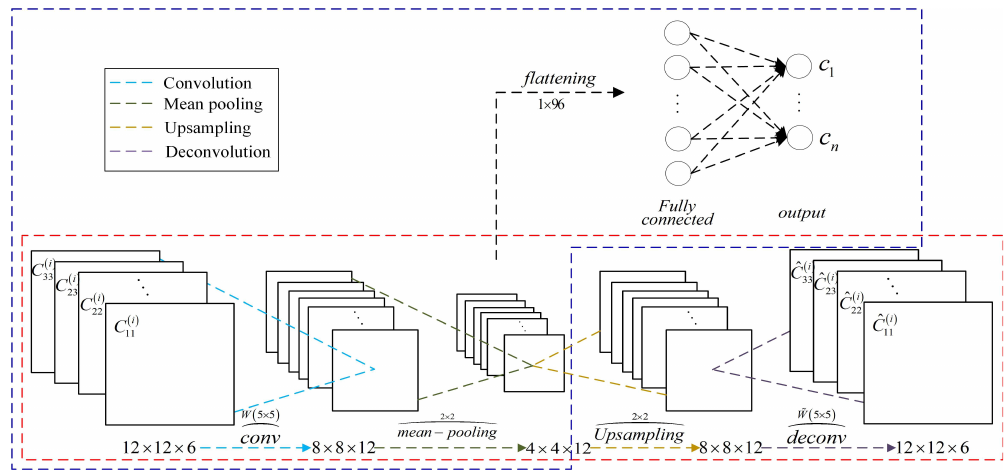
Figure 1. CV-CAE architecture. Red and blue boxes are the structure of the CV-CAE and classification network